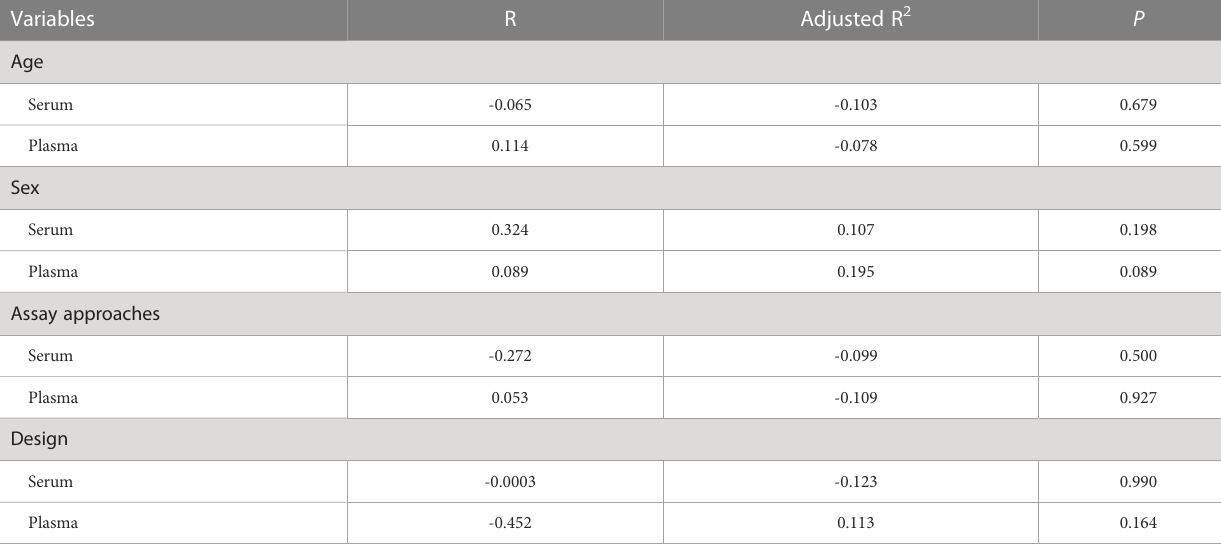
TABLE 4 Meta-regression analysis of variables predicting serum and plasma levels of leptin.